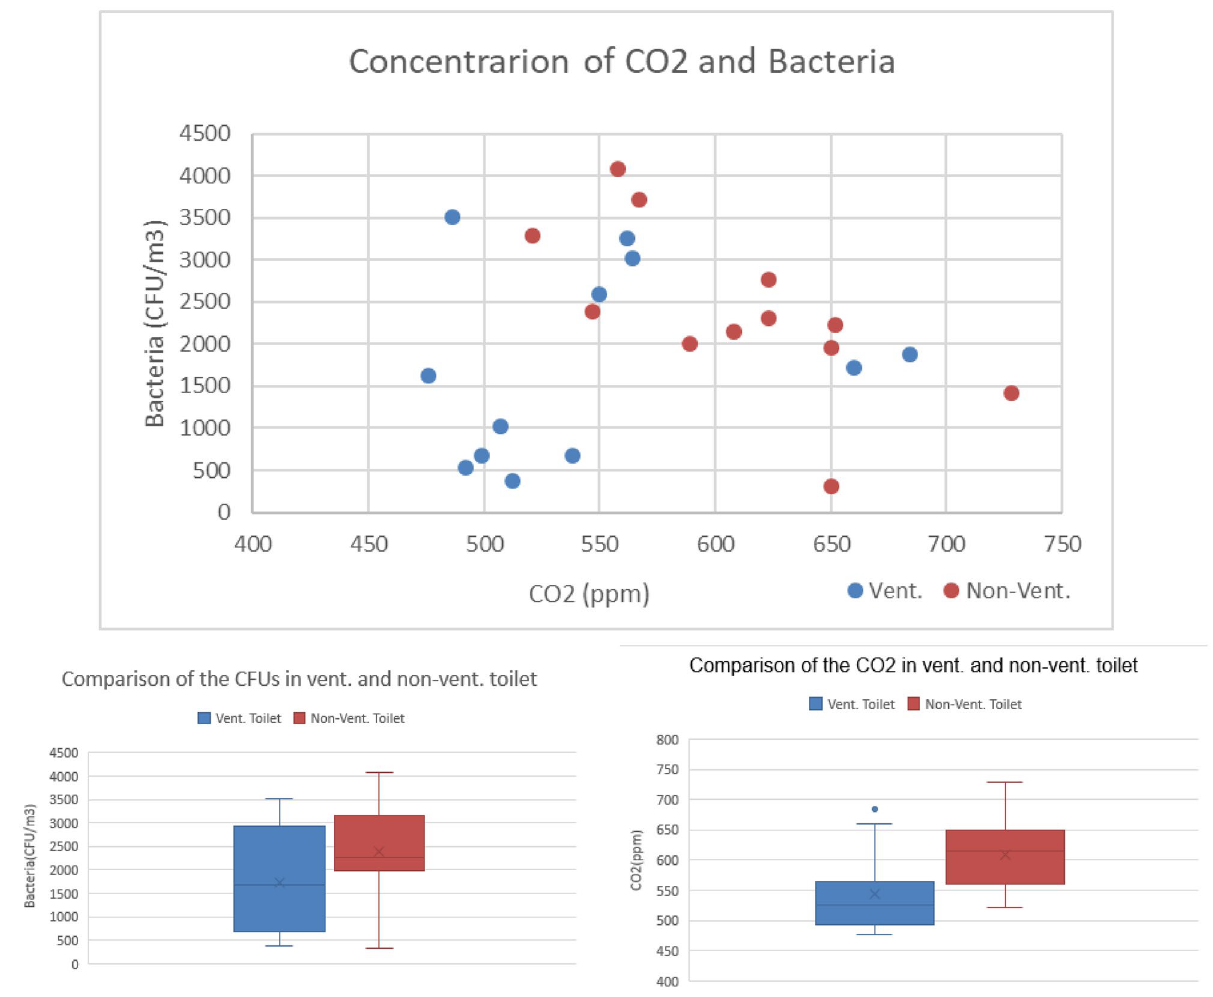
Figure 6. Comparison of the CFUs in ventilation toilet and non-ventilation toilet.